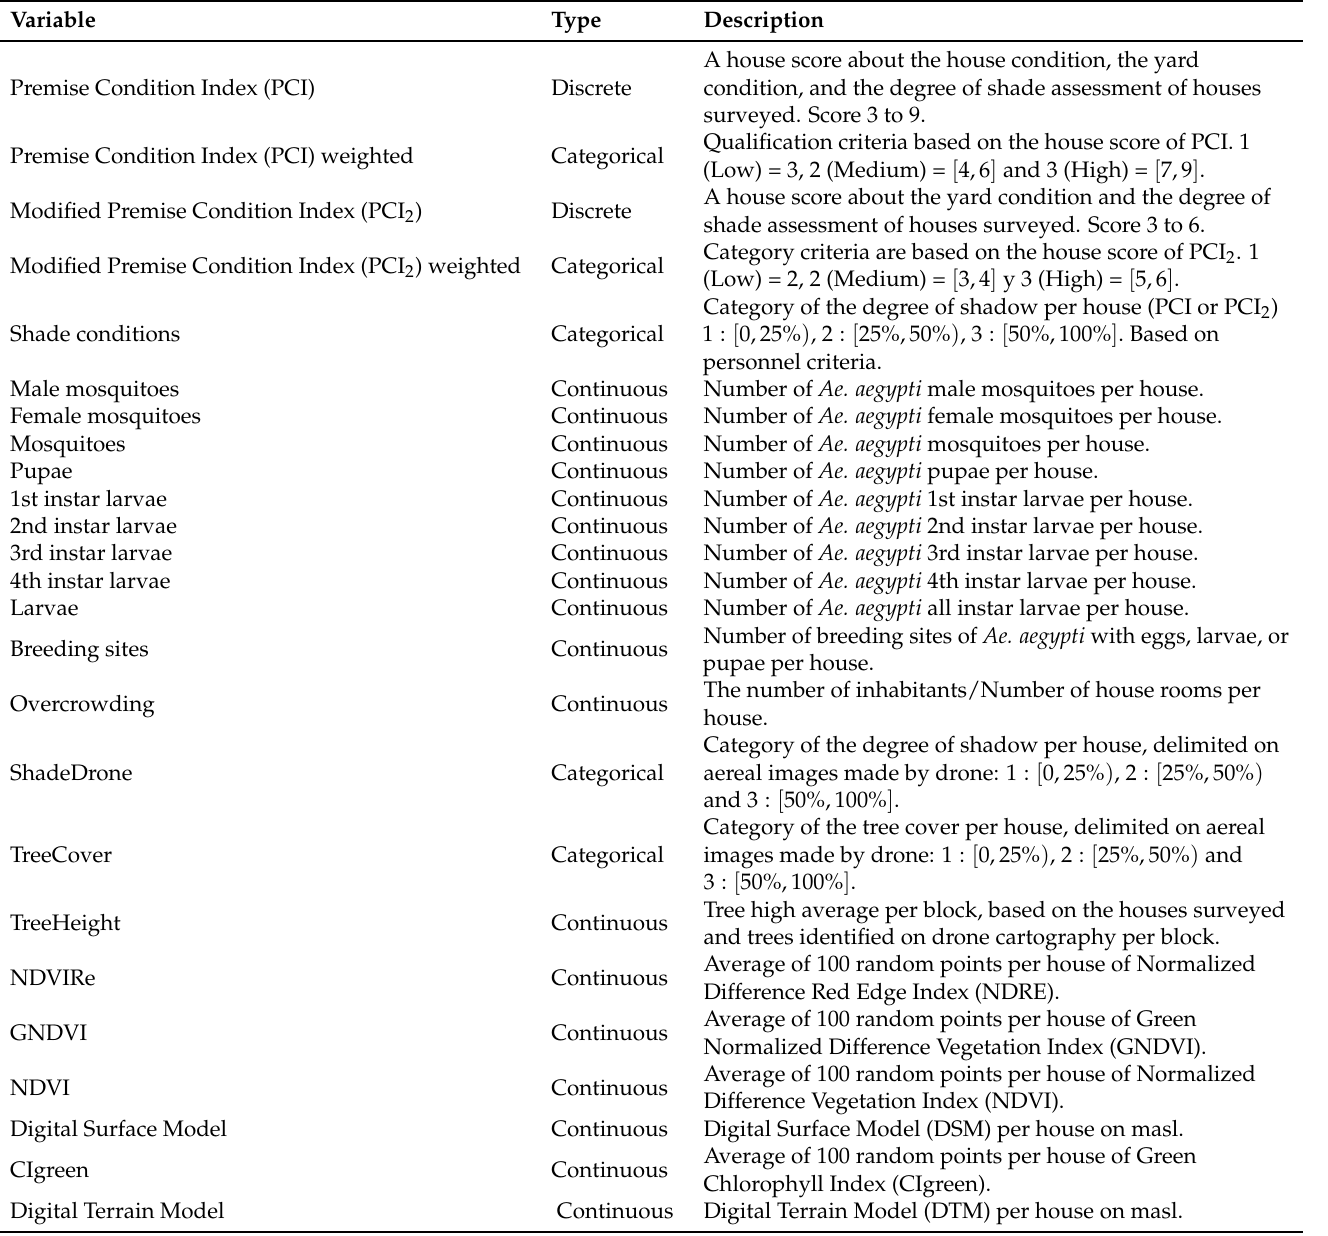
Table 1. Description of the variables obtained from field surveys and specialized cartography of El Vergel neighborhood, Tapachula, Chiapas,